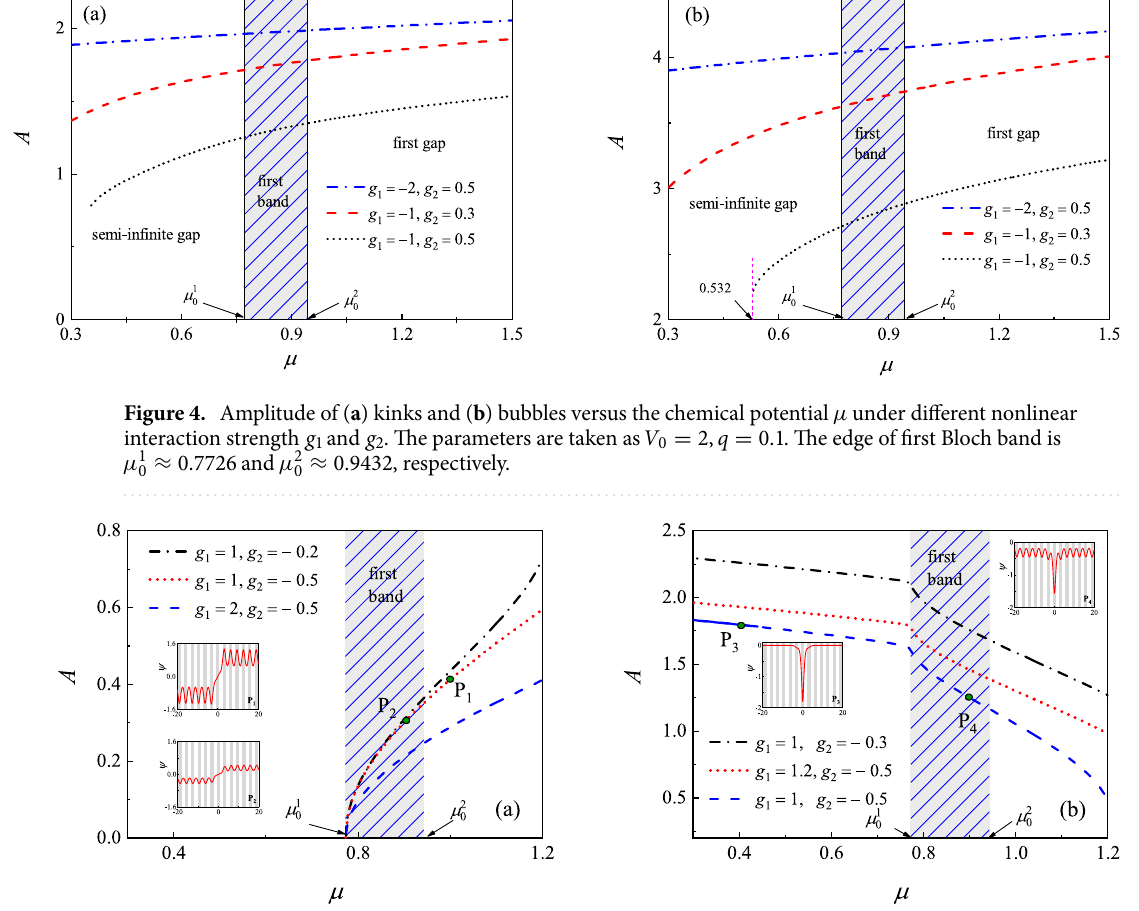
Figure 5. Amplitude of ( a ) kinks and ( b ) bubbles versus the chemical potential µ under different nonlinear interaction strength g 1 and g 2 . The profiles of solitons at the marked points are shown in the subplots, where the shaded regions represent lattice sites, i.e., regions of low potential values V ( x ). The dashed line denotes the unstable solitons while the solid line denotes stable ones. The parameters are taken as V 0 0.7726 and µ 2 0.9432 , of first Bloch band is µ 1 0 0 ≈ ≈